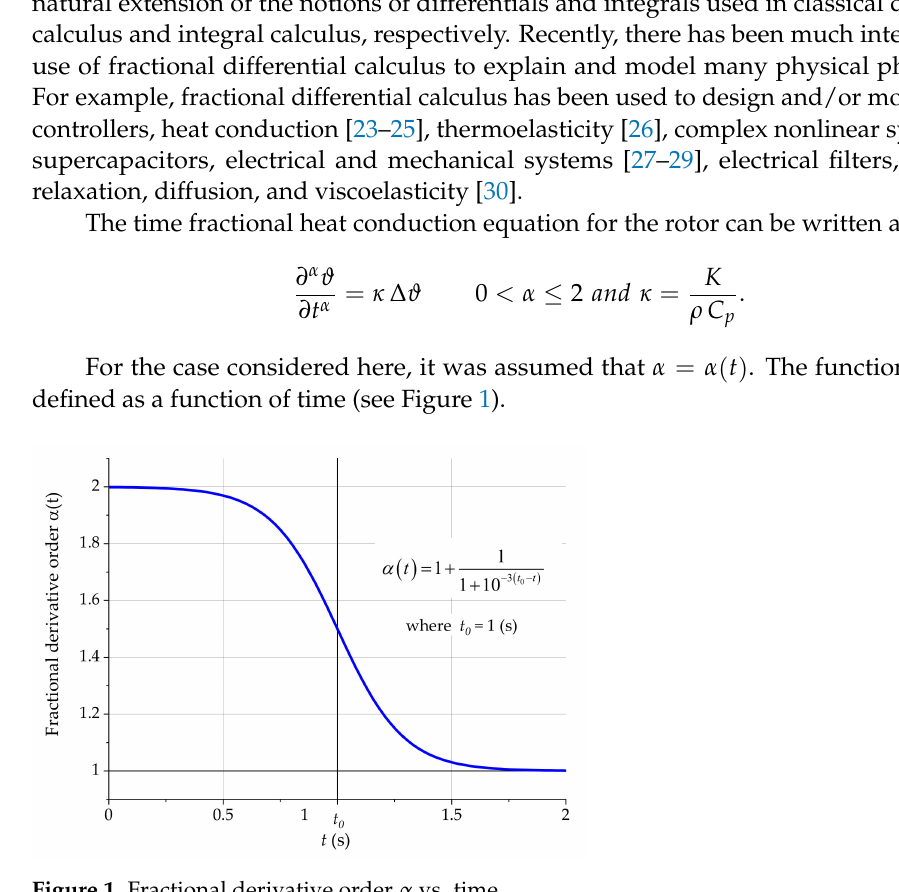
Figure 1. Fractional derivative order α vs.